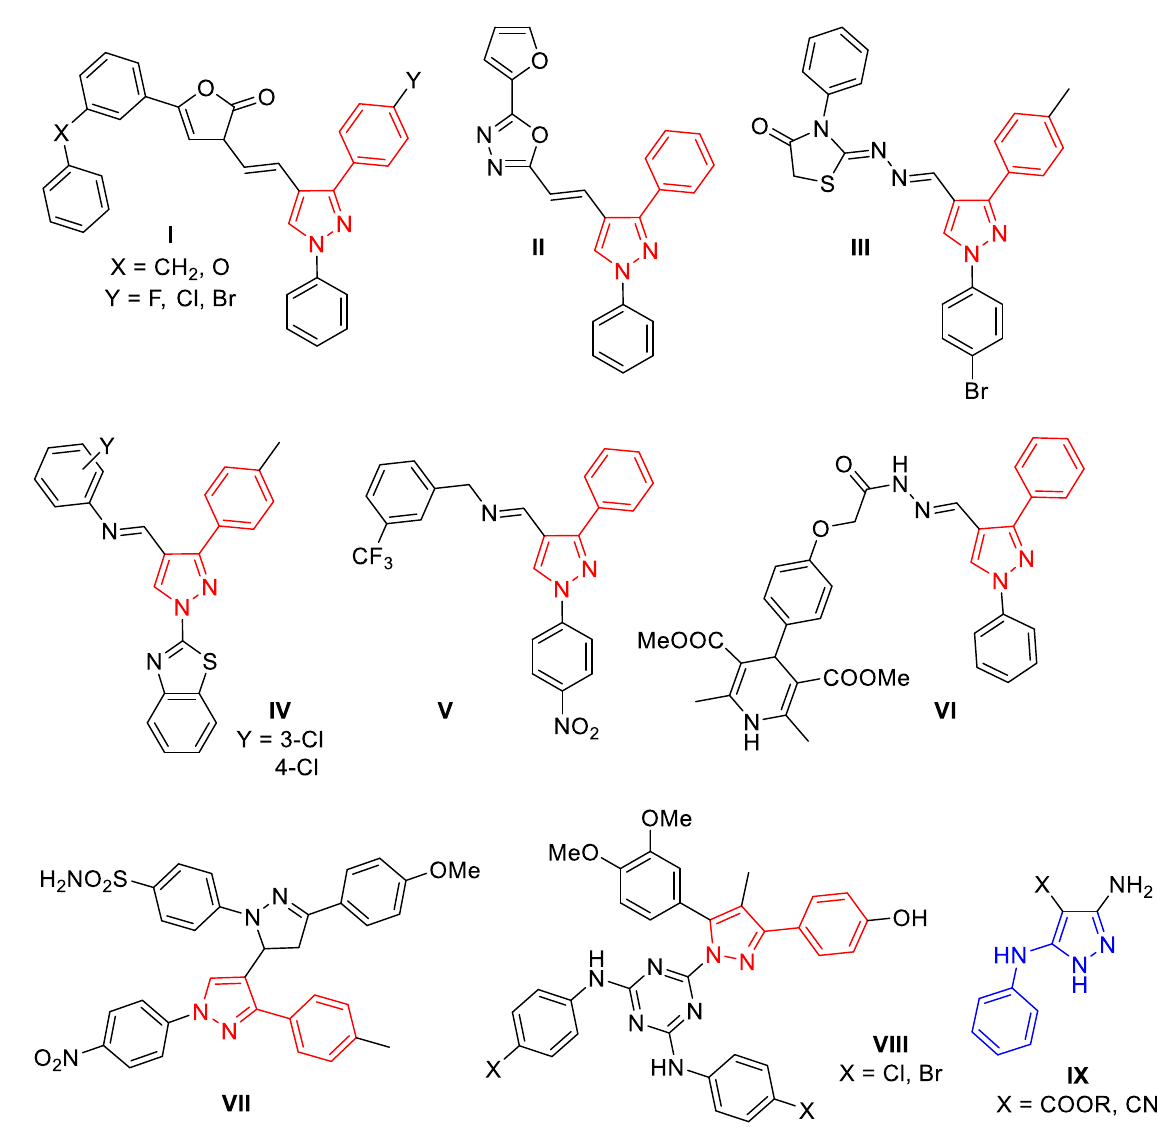
Figure 1. Tri- and tetra-substituted pyrazoles with antimalarial activity. The 3-phenylpyrazole and the anilino-pyrazole substructures are colored red and blue, respectively.